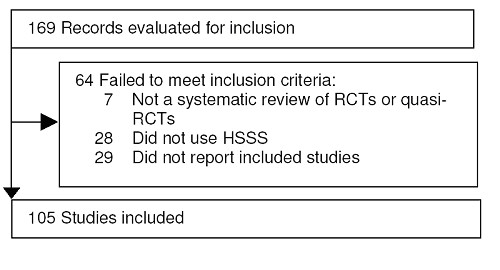
QUOROM Flow Diagram.